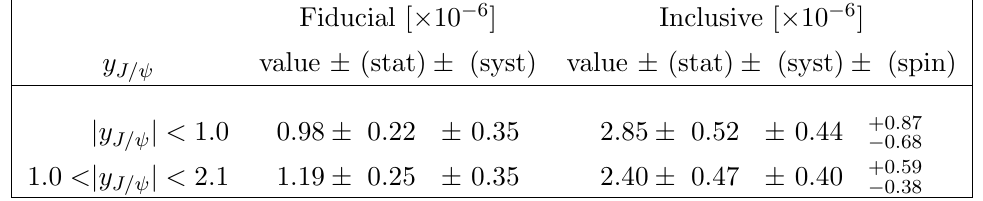
Table 7. The (cid:12)ducial and inclusive (SPS+DPS) di(cid:11)erential cross-section ratio in two regions of y . J=